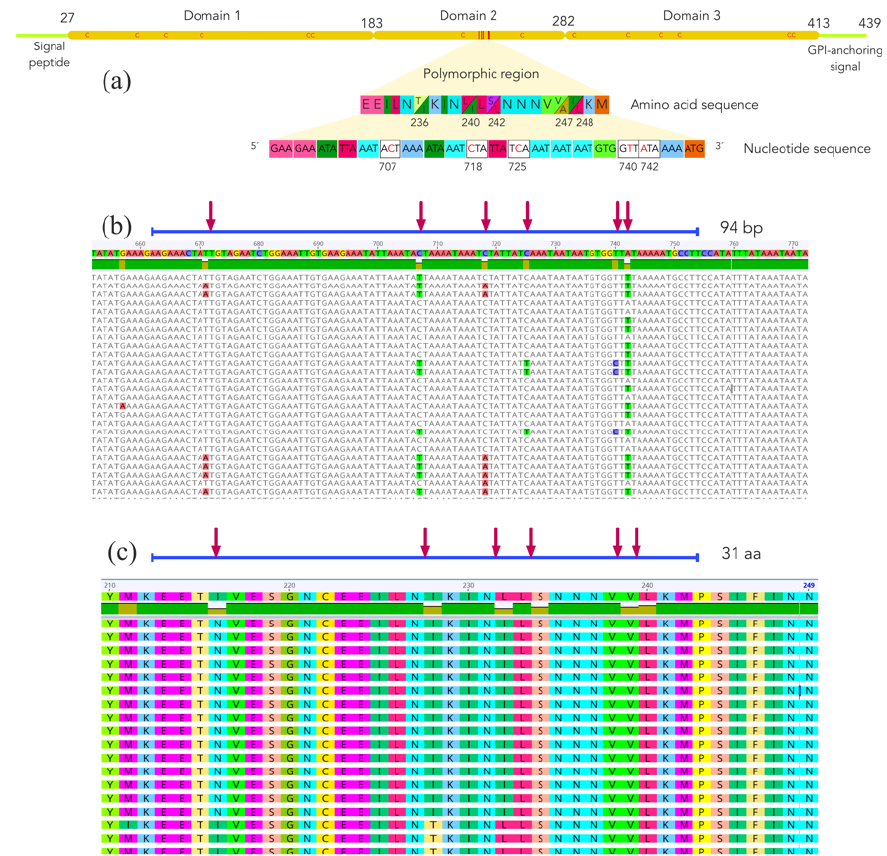
Figure 3. ( a ) Structure of the Plasmodium falciparum cysteine-rich protein PfS47, showing three domains and a variable region within domain 2. The letter “C” within the polypeptide chain indicates the approximate position of the cysteine residues. ( b ) Multiple nucleotide sequence alignment of the polymorphic region of the pfs47 gene. ( c ) Multiple amino acid sequence alignment of the polymorphic region of the PfS47 protein. Red arrows indicate polymorphic sites.